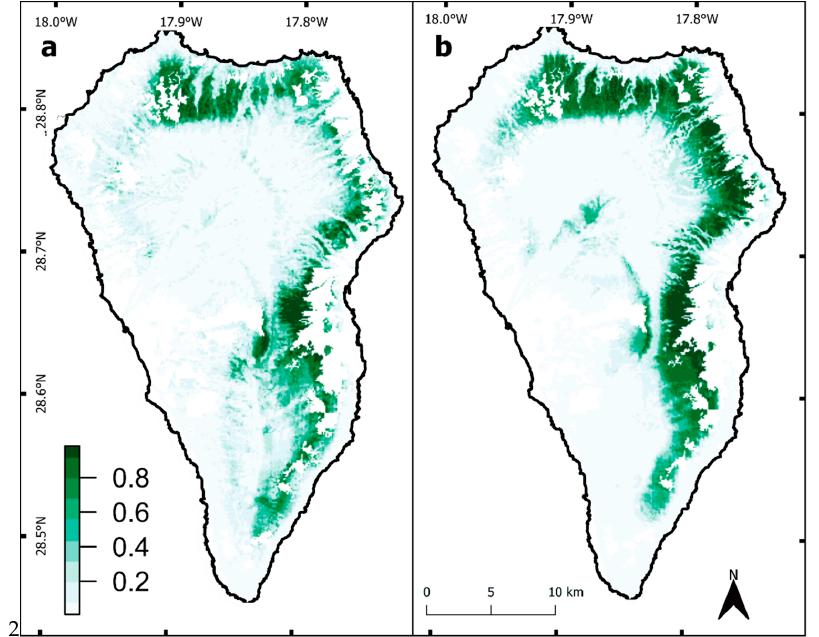
Figure 7. C. sativa habitat suitability maps obtained from the ecological niche modelling (ENM) using ensemble models (EM). ( a ) The map obtained from the model based on field-collected species occurrence data. ( b ) The map obtained from the model based on the species occurrence data derived from remote sensing. The vertical legend on the bottom-left shows the degree of suitability; values closer to 1 indicate comparatively higher habitat suitability.